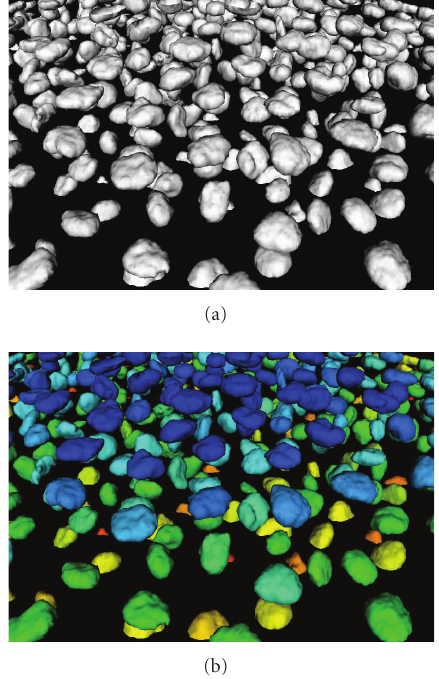
Figure 9: Segmentation of last volume of time lapse series. (a) Segmentation. (b) Connected